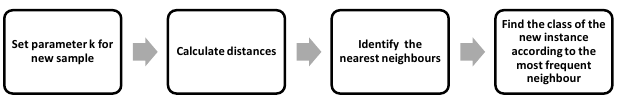
Fig. 3. K - nearest neighbo u r algorithm steps .